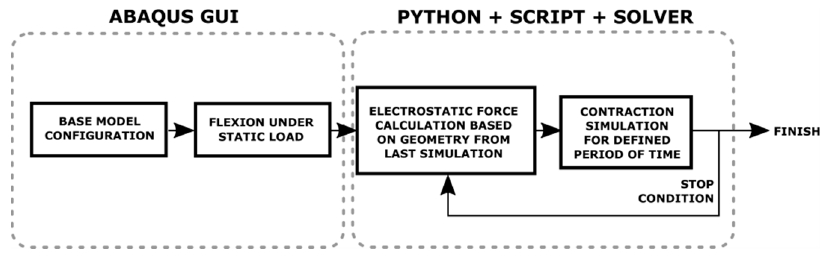
Figure 3. Schematic of the simulation